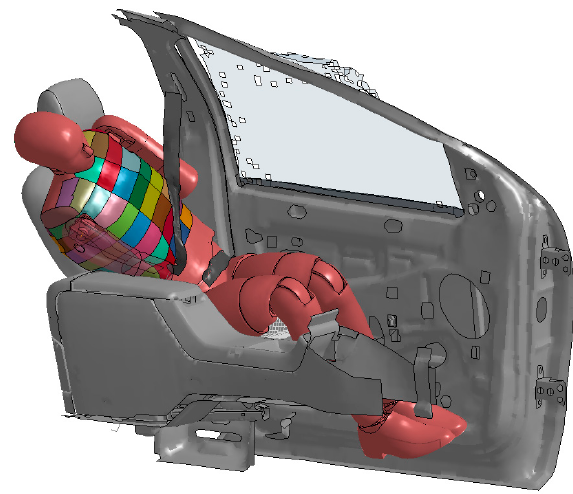
Figure 8. Position 1—ATD impacting the centre console at 2300 ms.